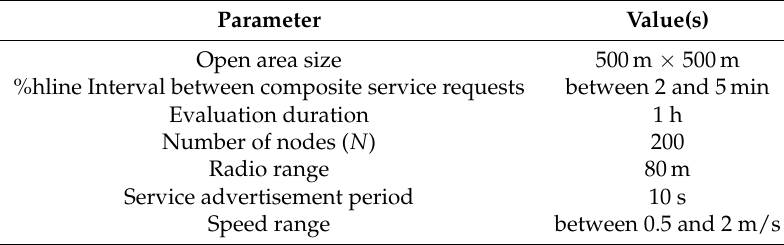
Table 2. Parameters common to all